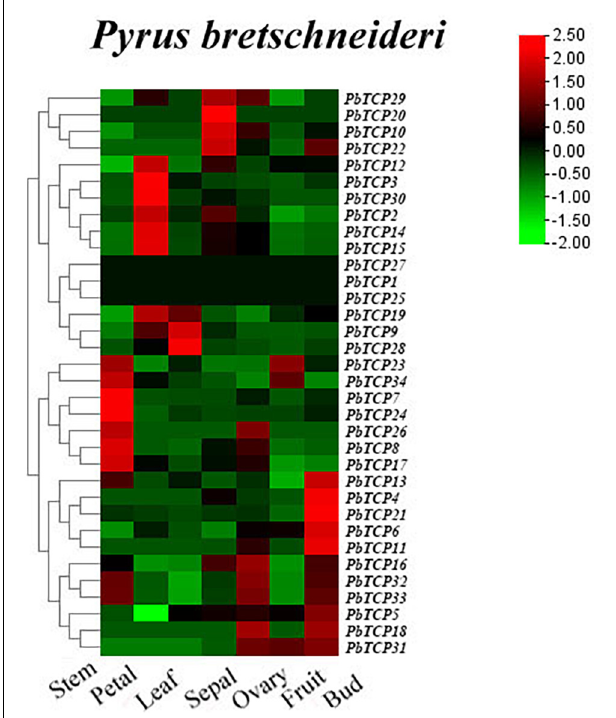
FIGURE 6 | Expression profiles of PbTCP genes in different tissues of Pyrus bretschneideri. The heatmap was generated by TBtools software according to the RNA-seq database. Log2-based-fold changes were used to create a heatmap. As shown in the bar at the upper right corner, the gene transcription level is expressed in different colors on the